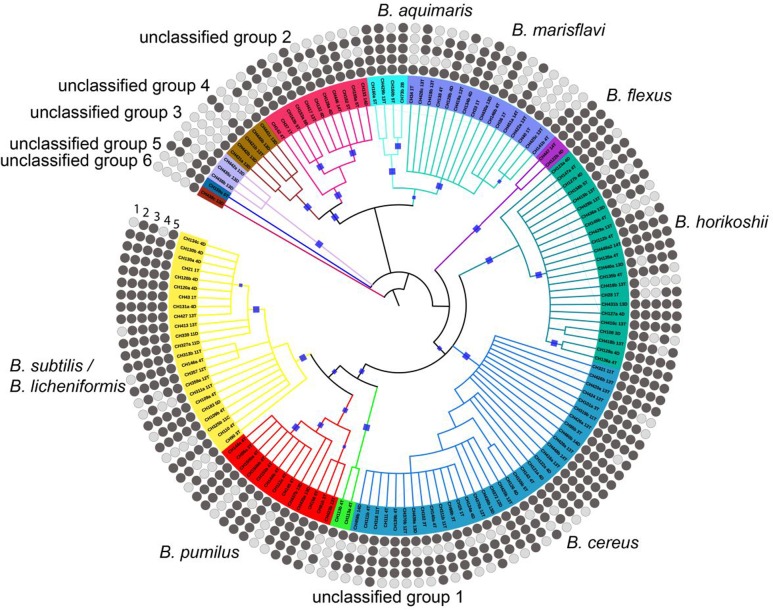
Variability in the utilization of different carbon sources by the different Bacillus taxonomic groups. Rings from the outside to the inside are designated by numbers for the carbon sources tested: (1) sorbitol, (2) raffinose, (3) trehalose, (4) xylose, (5) glucose. Dark and light circles indicate utilization and no utilization, respectively, of carbon sources. The phylogenetic reconstruction was made using 16S rRNA gene alignment and was based on the maximum likelihood method and the bootstrap values in the range from 0.8 to 1 were marked with blue squares.